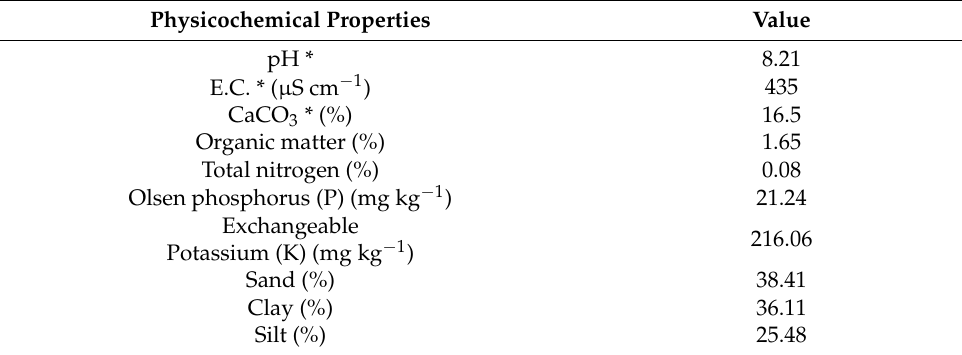
Table 1. Physicochemical properties of the used soil.